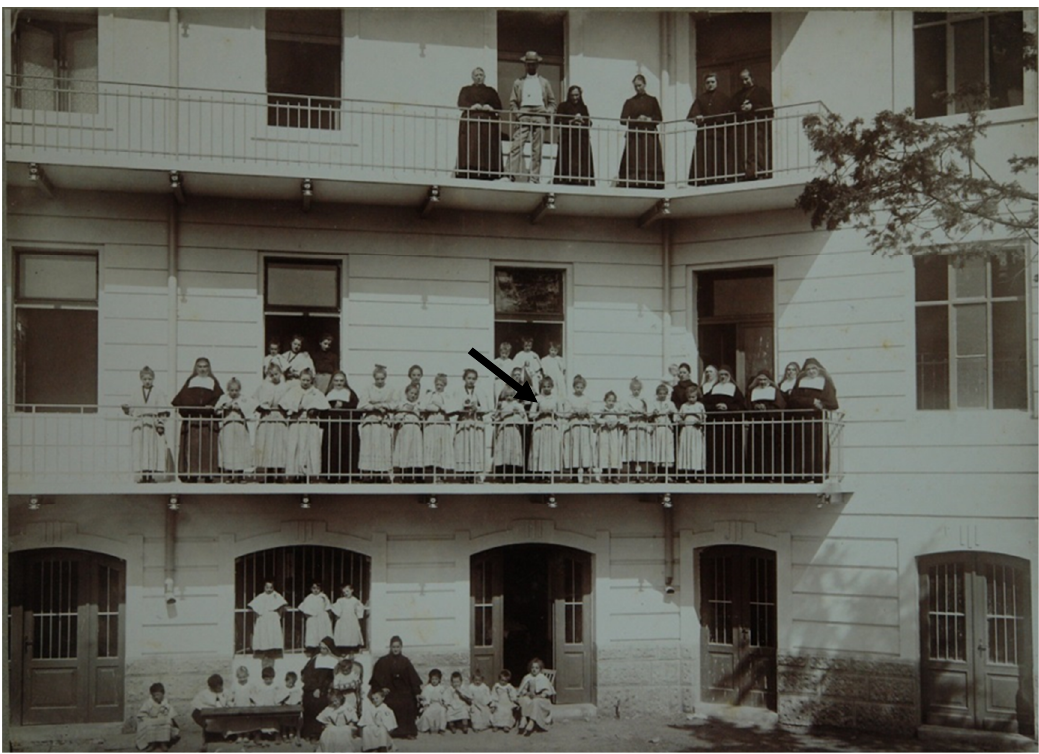
Figure 2. Sister Marija (first floor, holding a Jesus stature, in the center, arrow pointing at Sister Marija) with her brother (second floor), sister Tereza (first floor, holding a baby in her arms, closest nun to Sister Marija on the right), and monastery nuns and orphans.